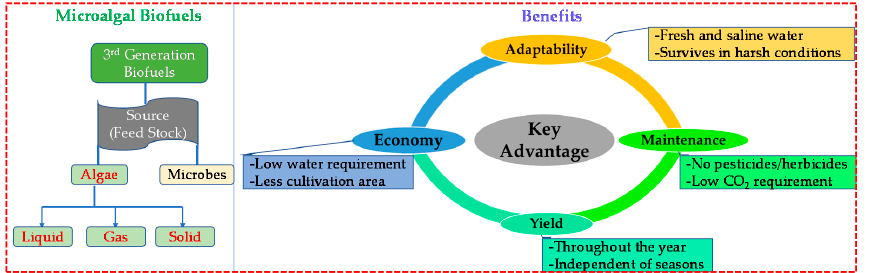
Figure 4. Key advantages of third generation